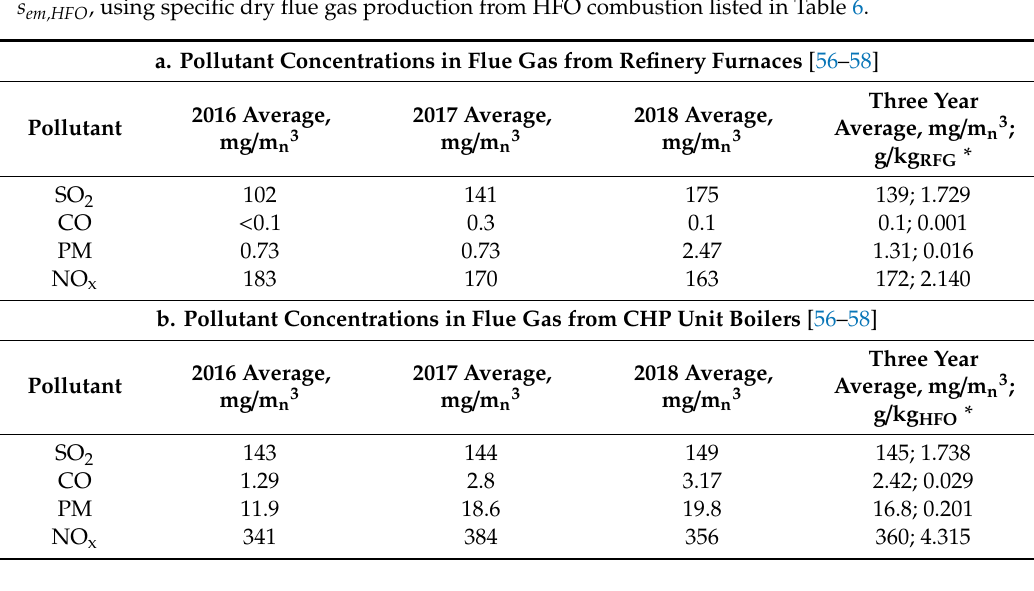
Table 7. a. Pollutant concentrations in flue gas from refinery furnaces [56–58]; *—recalculated to